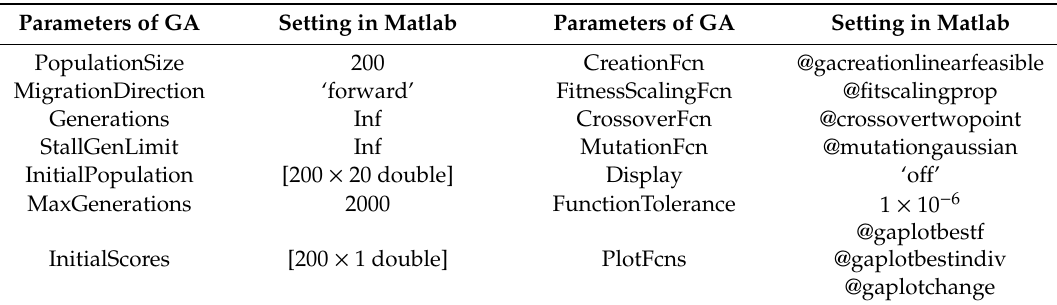
Table 1. The parameters setting of GA in Matlab.